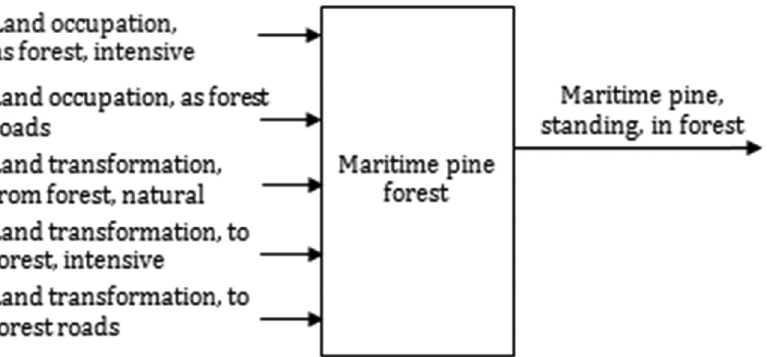
Figure 1: Gate - to - gate system